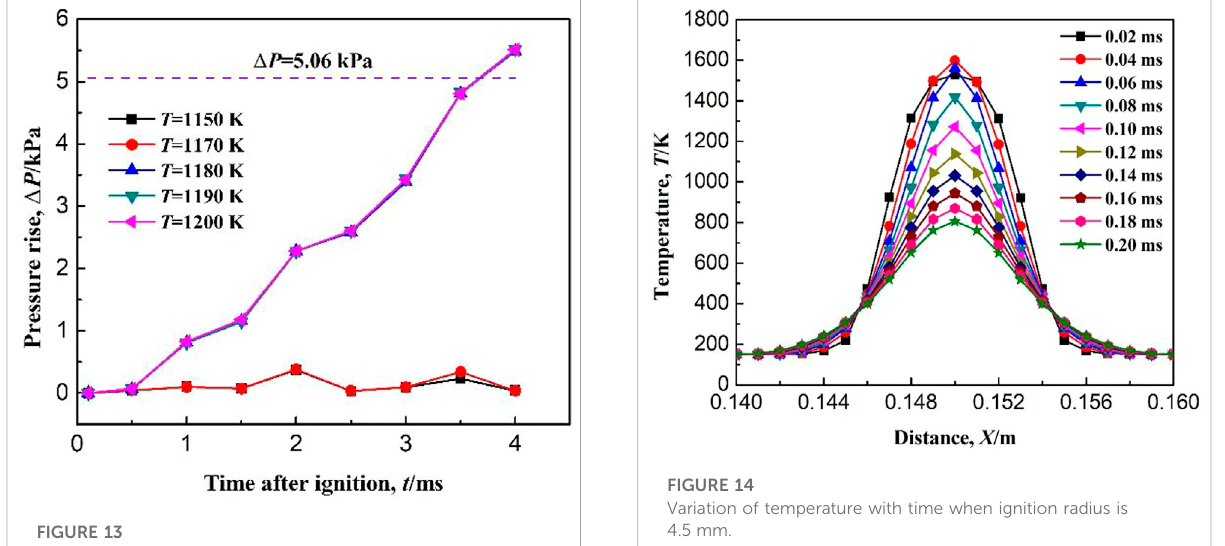
FIGURE 13 Pressure rise for different ignition temperature.